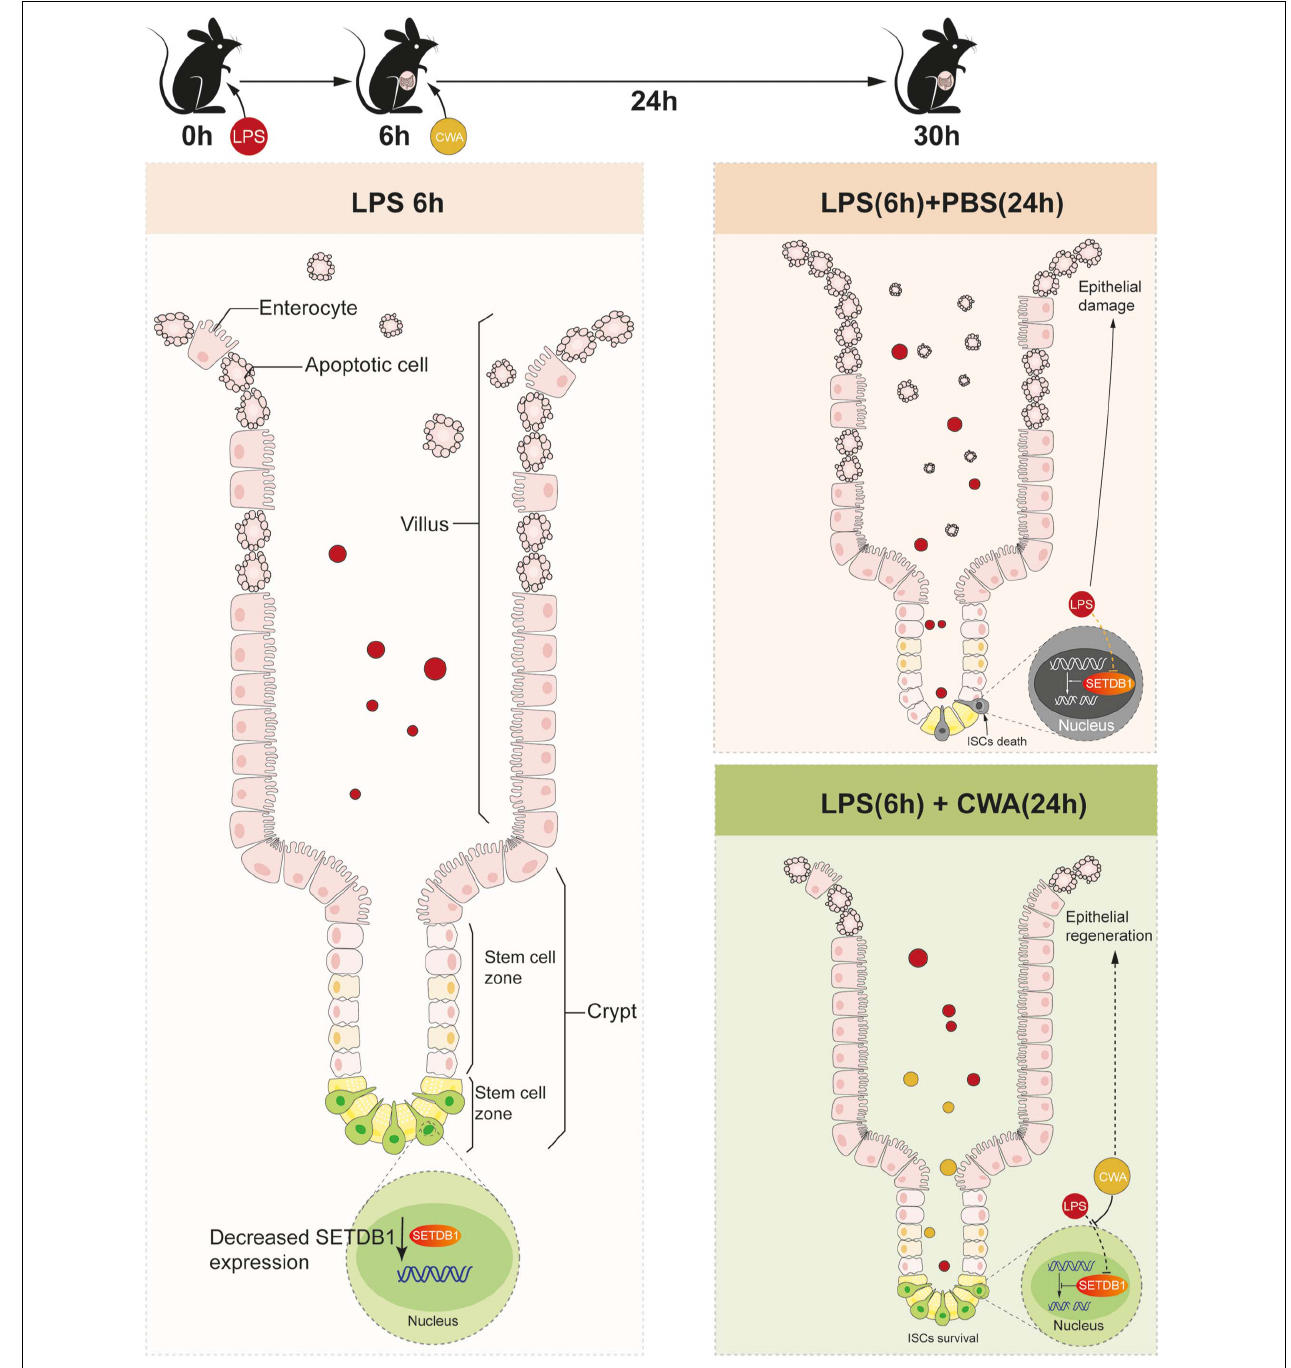
FIGURE 6 | Schematic Diagram. Decreased expression of SETDB1 was found within 6 h after LPS treatment and short-term reduction of SETDB1 didn’t lead to DNA damage. CWA treatment significantly restores the decreased expression of SETDB1, thus exhibiting beneficial regulation on genome stability and preventing DNA damage. Stabilized genome enables ISCs to survive under infection conditions and promotes